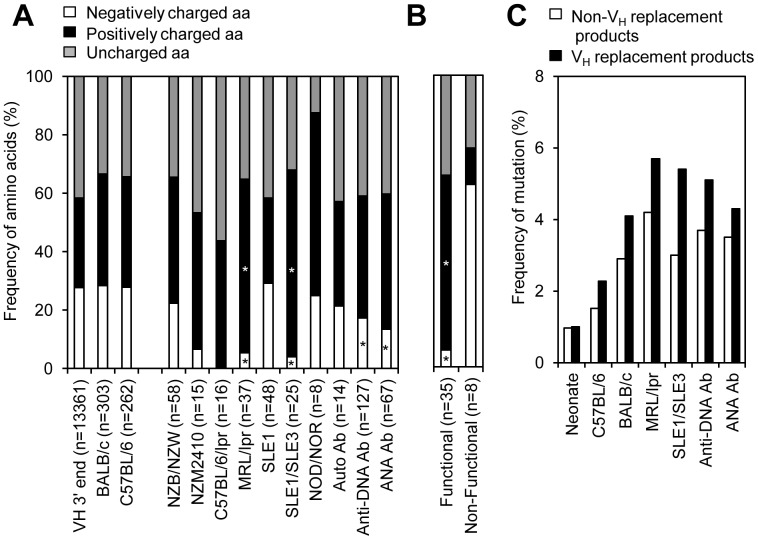
The enriched VH replacement products identified in different strains of autoimmune prone mice or IgH genes encoding autoantibodies have been positively selected during autoimmune responses.(A) Analysis of the frequencies of positively charged versus negatively charged amino acids encoded by the 3′ end VH genes and the identified VH replacement footprints from different strains of mice or IgH genes encoding autoantibodies. Statistical significance was determined using a two-tailed Chi square test with Yate’s correction. p<0.05 (*) is considered significant. (B) Comparison of the amino acids encoded by the identified VH replacement footprints in MRL/lpr mice. n, numbers of amino acids encoded by the identified VH replacement footprints. (C) Mutation status analysis of identified VH replacement products and non-VH replacement products from different subgroups of IgH genes.